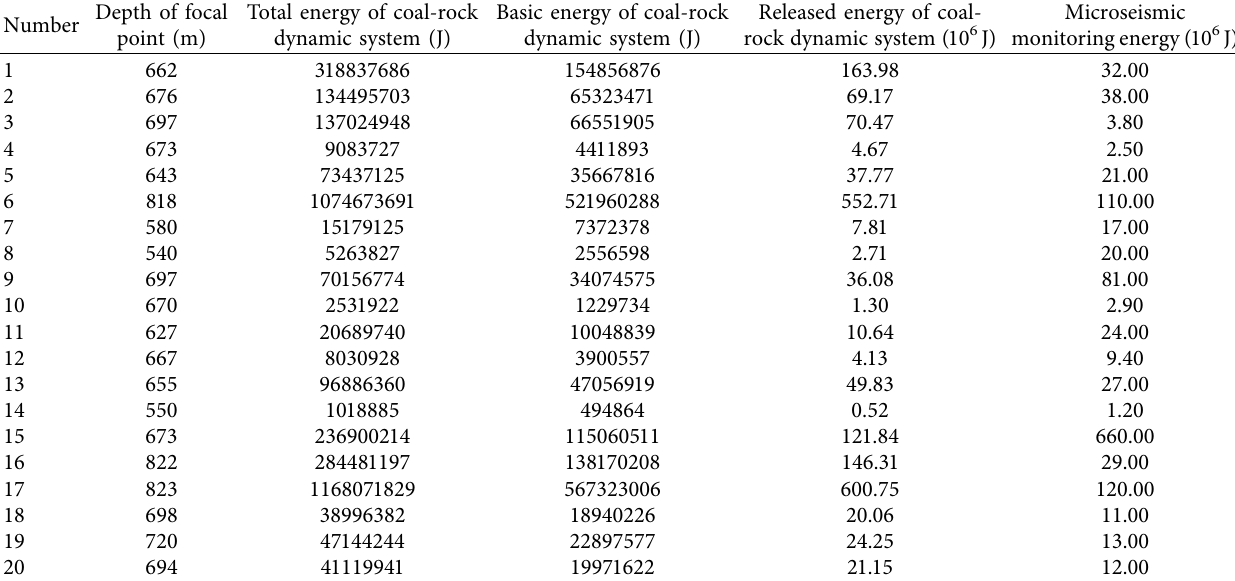
Table 2: Release energy by the coal-rock dynamic system in part rockburst of one coal